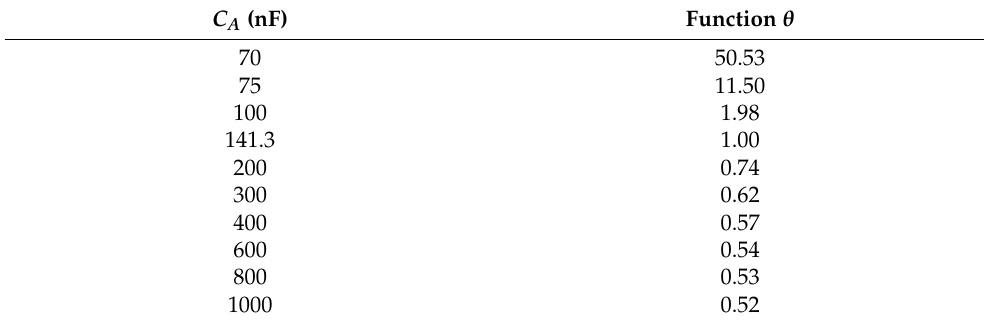
Table 1. Function θ evaluated as a function of C A with V DD = 3.3 V, V TH = 1.36 V, and C B = 47 nF. C A